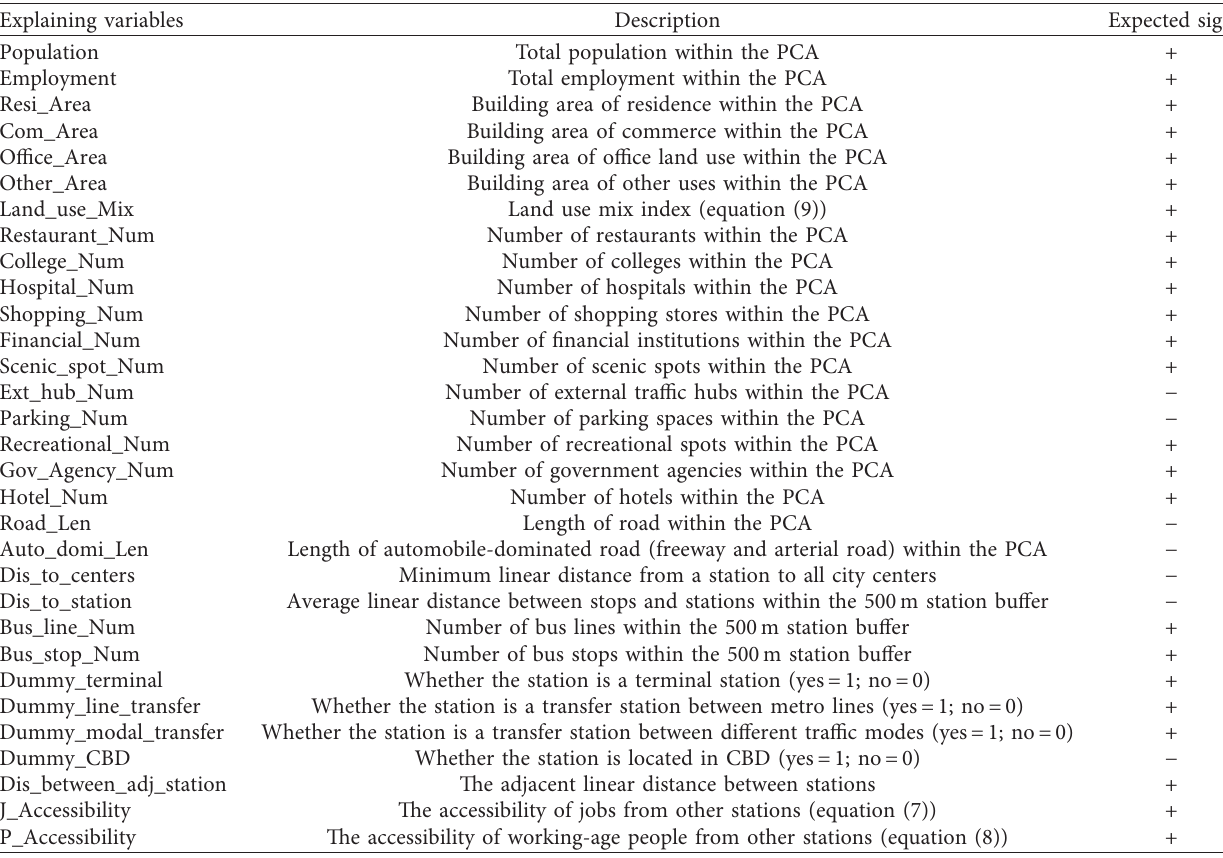
Table 2: Description of candidate